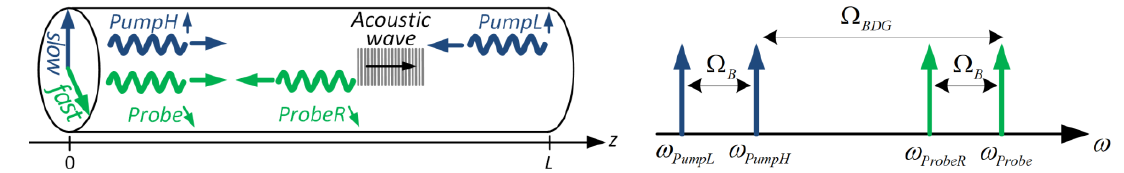
Figure 1. Brillouin dynamic grating principle of operation in polarization maintaining fibers.